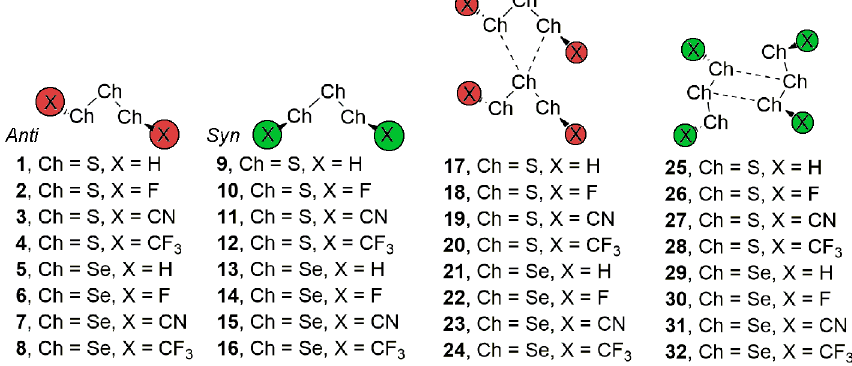
Figure 1. Compounds 1 – 16 and complexes 17 to 32 studied in this work.